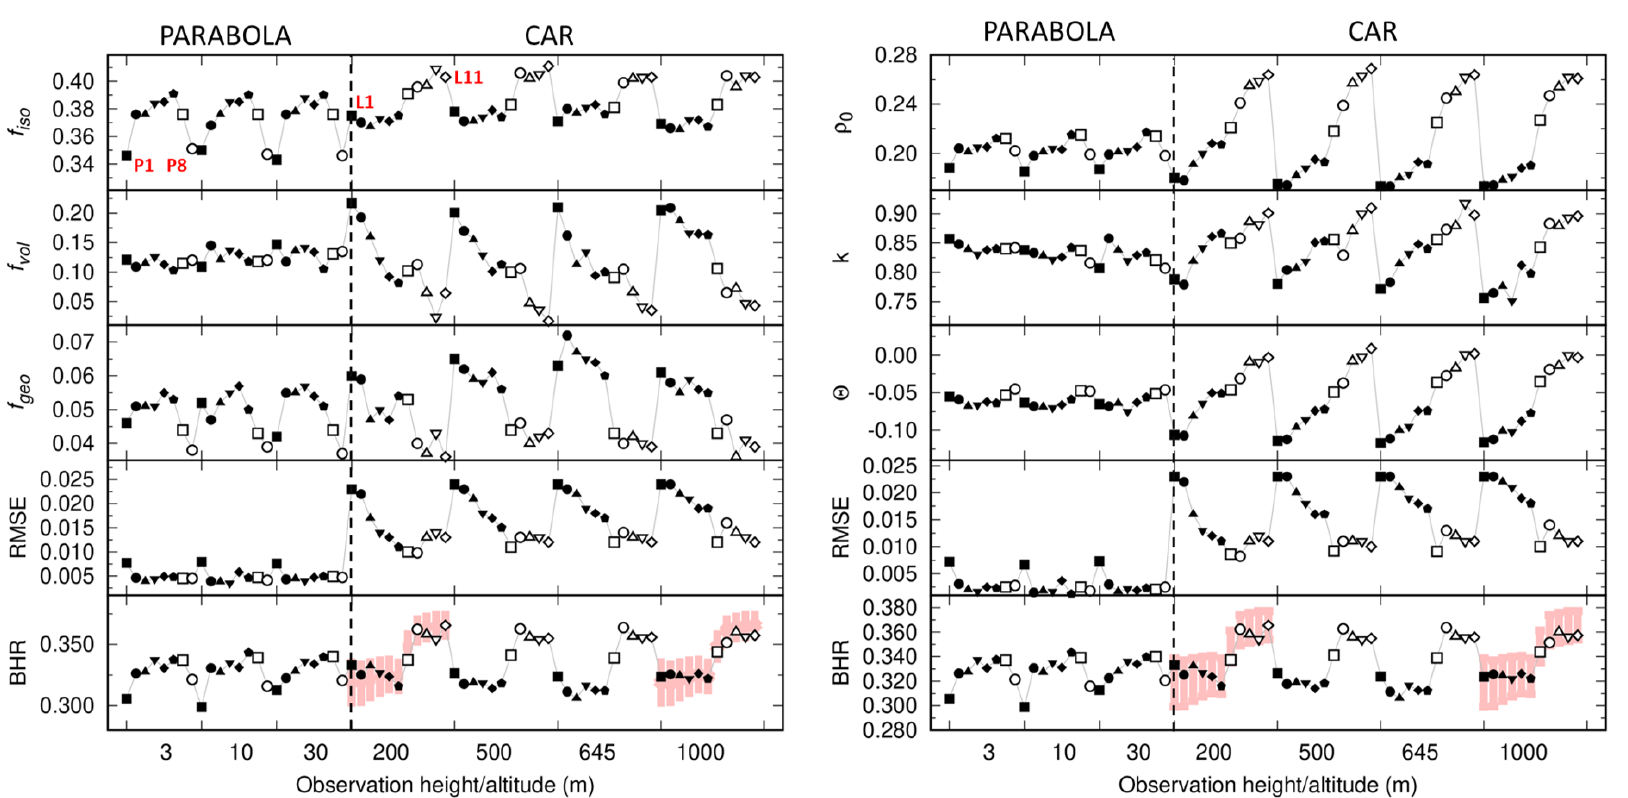
Figure 10. Results of the optimization of RTLS ( left ) and RPV ( right ) BRDF functions as performed over eight locations for PARABOLA (3, 10 and 30 m) and eleven locations for CAR ( ≥ 200 m). For each set of points, the values relevant to the N-W area of the Railroad Valley Playa (RRV) are marked by filled symbols (P1-P6, L1-L6), while open symbols refer to the S-E area (P7,P8, L7-L11). P1–P6: filled square, circle, upper triangle, . . . , diamond; P7–P8: open square and circle. Pink shadows show the range of reference BHR ± σ over the corresponding sampled